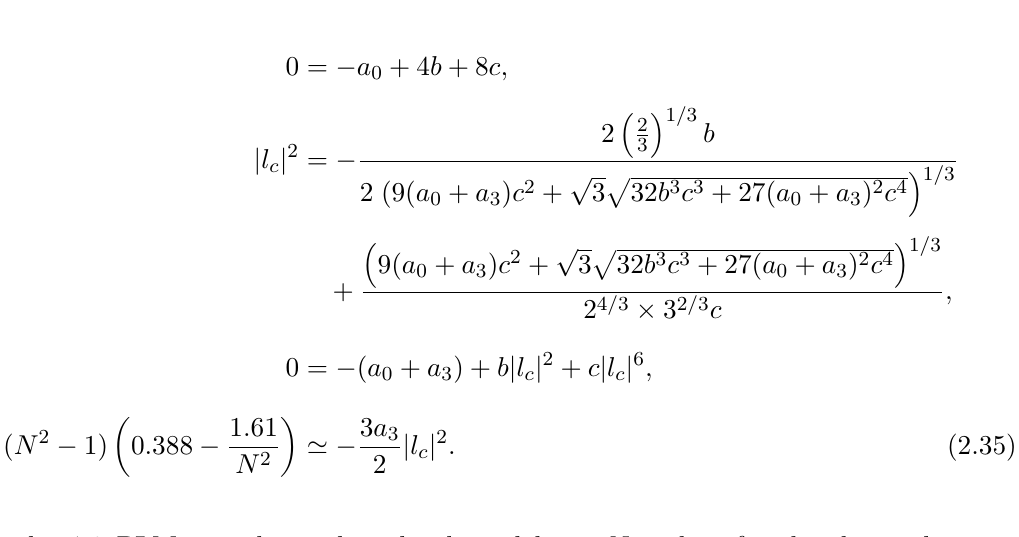
Figure 3 . Fitting the N = 4 4-8 PLM to the thermodynamic quantities of SU(4) PYM theory. Left panel: thermodynamic quantities as a function of T/T with the best fit parameters listed in table 1 c corresponding to the case N = 4 for the 4-8 PLM. Right panel: the same for the case N = 4 1 the best-fit parameters in the list of the 4-8 PLM, in table 1. The LS fit has been worked out only for 1 ≤ T/T 1 . 5 (focusing on the criticality regime) in the left panel, as zoomed-in the sub-small c ≤ window, while in the right panel for 1 ≤ T/T 4 c ≤